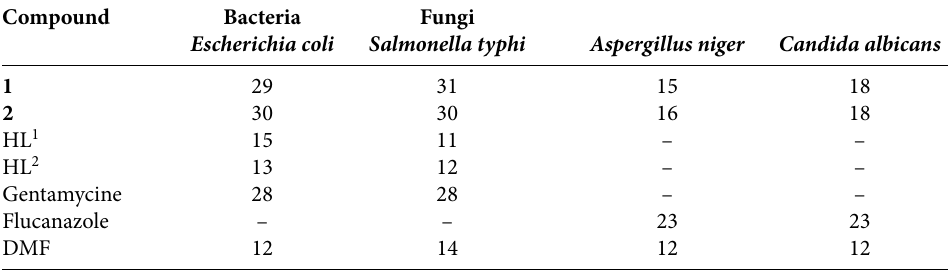
Table 3. Antimicrobial activities of the compounds (zone of inhibition in mm) Compound